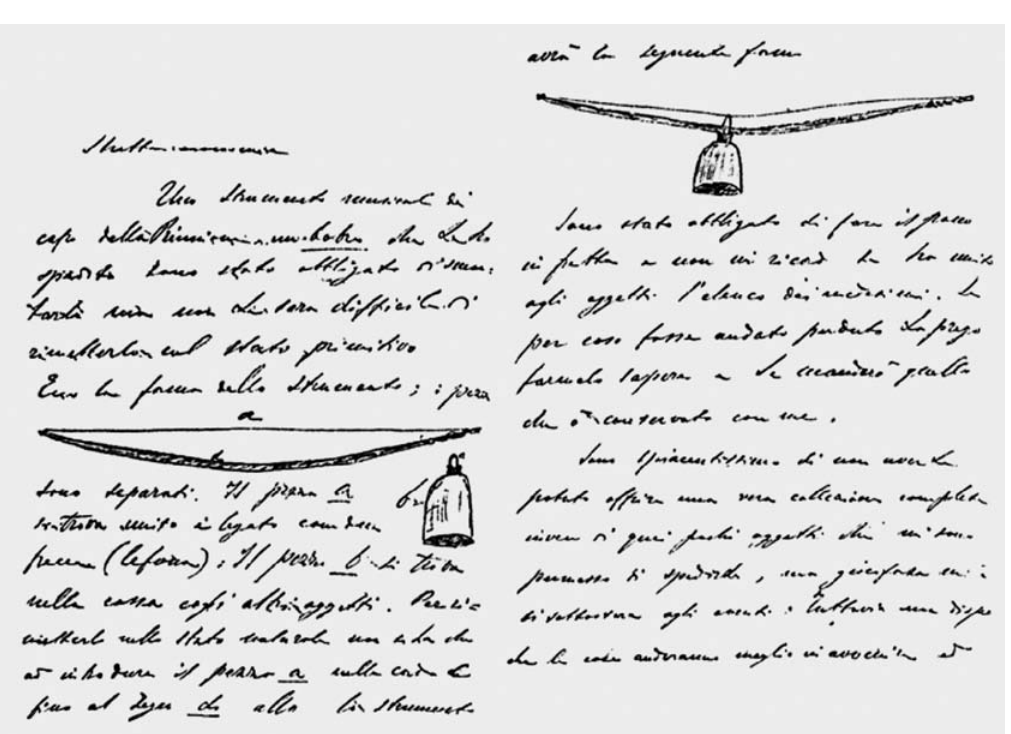
Fig. 4. Fragments of the letter of Mantovani to the Italian ethnologist Luigi Pigorini, in which the delivering of some musical instruments of Madagascar is announced, with a drawing of them ( Archives of the Pigorini Ethno- graphic Museum, Rome )